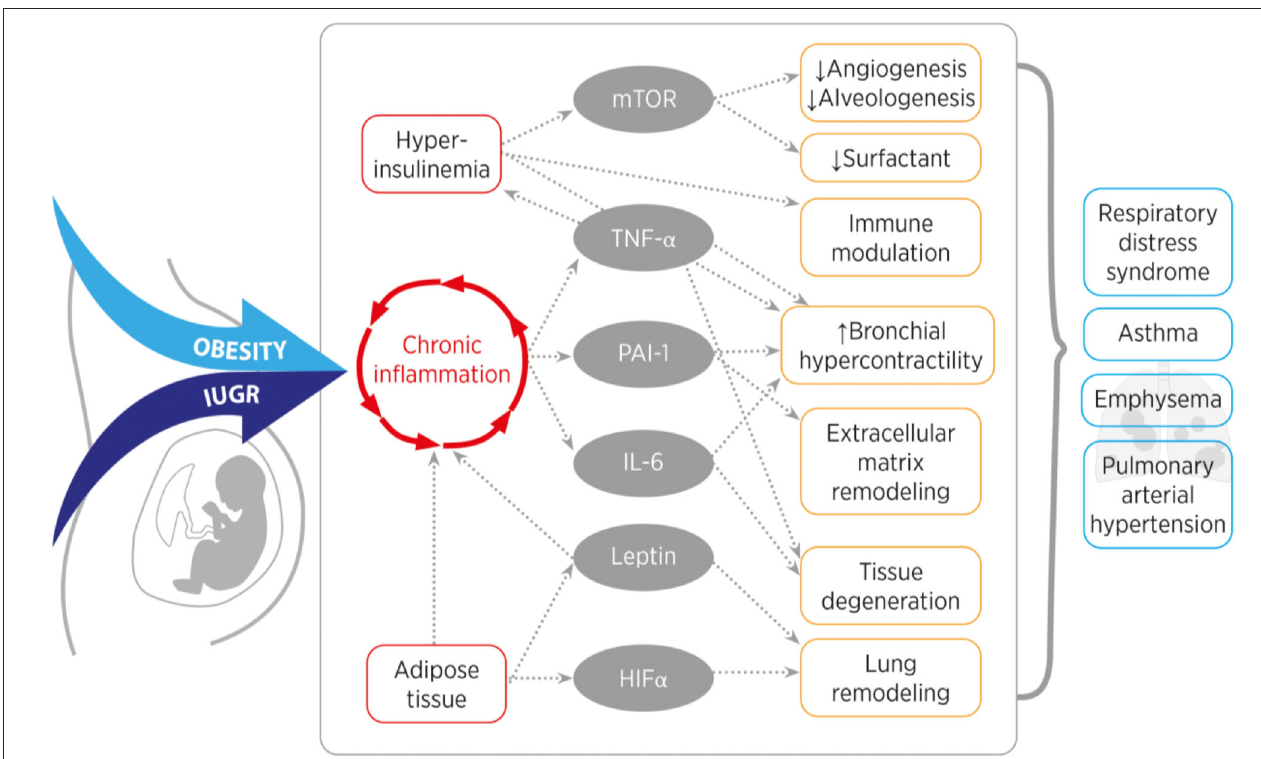
FIGURE 3 | Overview of the converging inflammatory signaling and nutrient sensing pathways of obesity and intrauterine growth restriction (IUGR). Obesity or IUGR lead to chronic inflammation and hyperinsulinemia, which induces mTOR, TNF- α , PAI-1, IL-6, Leptin, and HIF- α signaling. In the lung, these signaling molecules cause for example tissue remodeling, reduce alveolarization and induce smooth muscle cell hyperreactivity. These features are characteristics for a higher susceptibility to develop a chronic lung disease in later life. [mTOR (mechanistic target of rapamycin), TNF- α (tumor necrosis factor alpha), PAI-1 (plasminogen activator inhibitor-1), IL-6 (interleukin-6), HIF- α (hypoxia inducible hypoxia-inducible factor